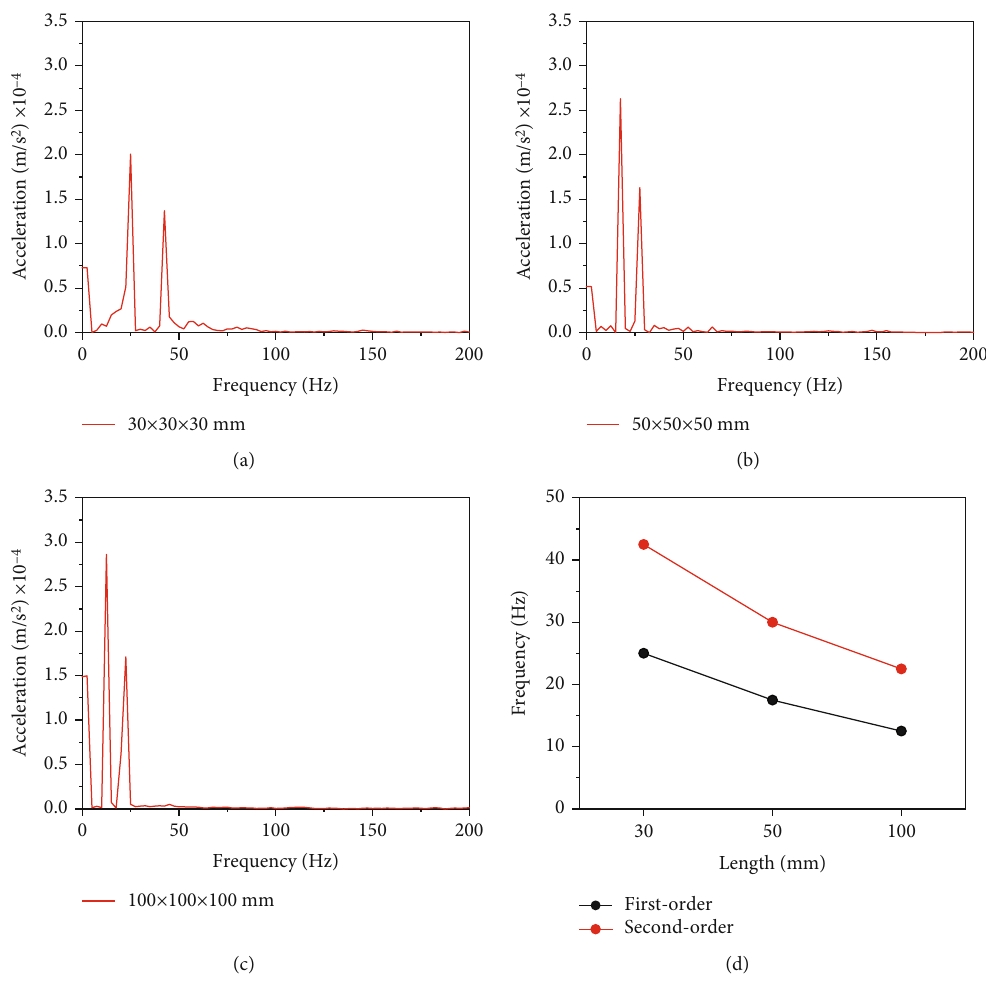
Figure 8: Frequency domain diagrams and natural frequency variation pattern diagram of di ff erent-size dried lignite coal